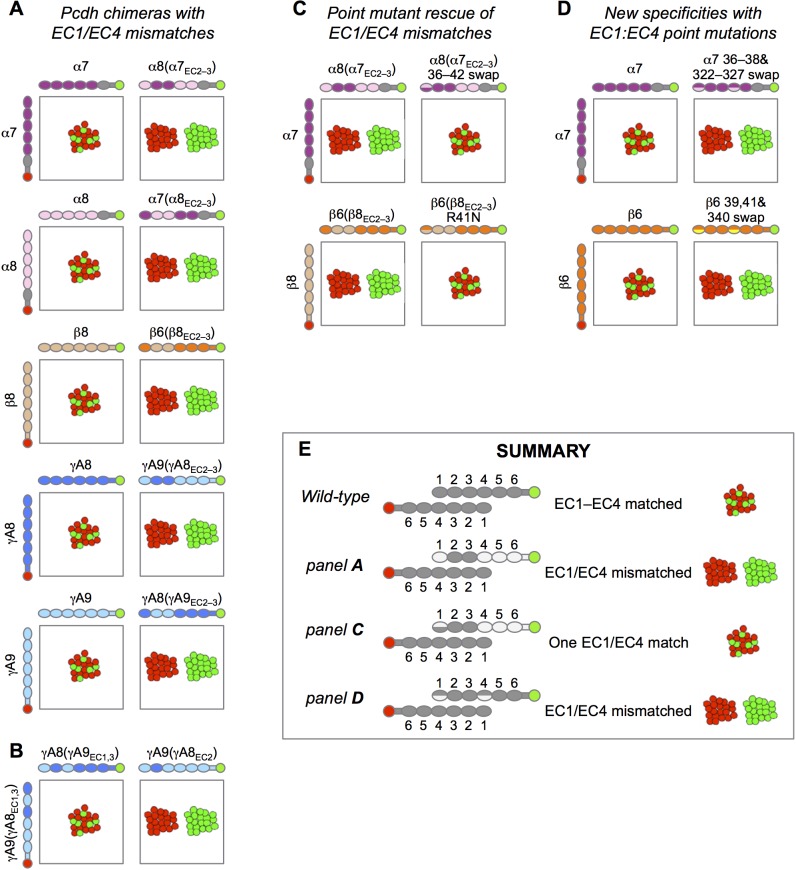
Experimental evidence for EC1:EC4 interactions contributing to Pcdh specificity.Schematic depiction of the published results of mixed K562 cell aggregation assays. Each panel shows the results of mixing two cell populations: one expressing an mCherry-labeled Pcdh (red), and one expressing an mVenus-labeled Pcdh (green). (A) Data from Figure S3 in Rubinstein et al. (2015). When the both cell populations express the same Pcdh, mixed red/green cell aggregates form (left column). However, when a Pcdh chimera containing EC1 and EC4 from a different Pcdh is expressed, these cells no longer mix with the wild-type Pcdh (right column). (B) Data from Figure 6B in Rubinstein et al. (2015). Expression of chimeric molecules with matched EC1:EC4 and EC2:EC3 interactions results in recognition and the formation of mixed aggregates (left), whilst a mismatched EC1:EC4 interaction results in separate aggregates (right, homophilic binding preference). (C) Data from Figure 5 in Rubinstein et al. (2015). Point mutation of EC1 interfacial residues to those of the wild-type parent molecule restores binding of EC1/EC4 mismatched chimeras to the wild-type Pcdh. (D) Data from Figure 5 in Goodman et al. (2016). Point mutations in interacting EC1:EC4 residues from those in the wild-type Pcdh to those of a different Pcdh isoform from the same subfamily (α7 with α8 EC1:EC4 residues above and β6 with β5 EC1:EC4 residues below) results in generation of a new specificity with homophilic binding preferences with respect to the wild-type Pcdh. (E) Summary of the results shown in this figure.